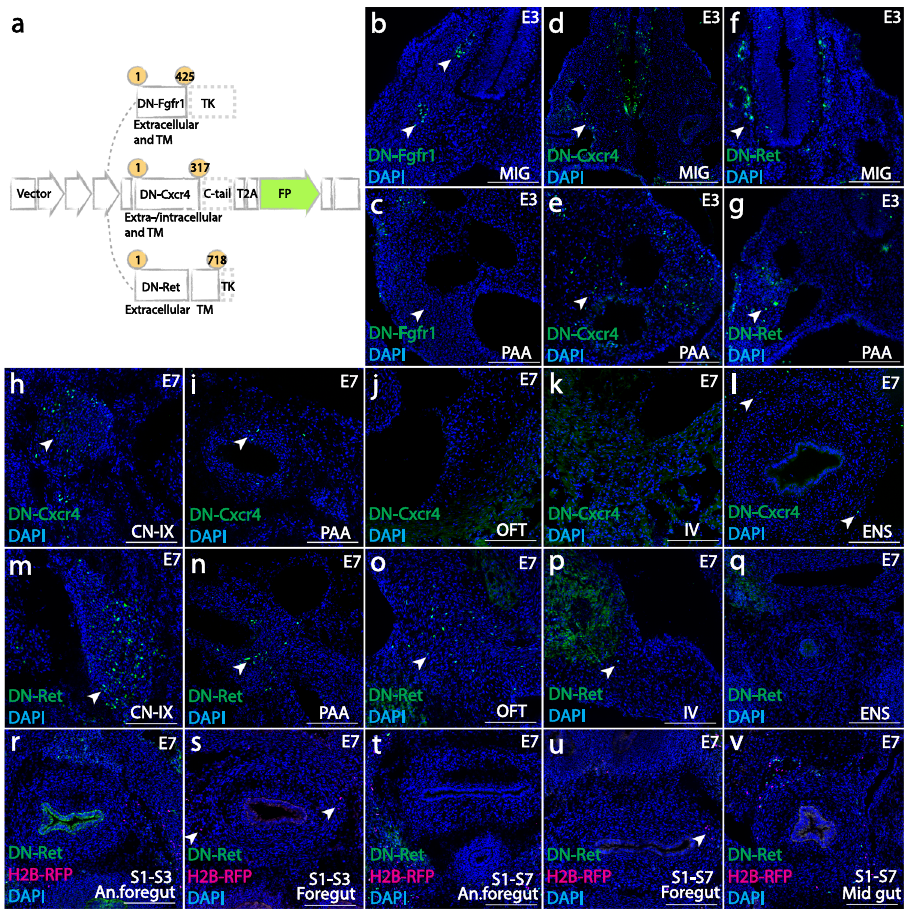
Fig. 5 Molecular cues required for vagal neural crest cells to adopt cardiac and enteric fates. a Viral constructs over-expressing dominant-negative mutants of Fgfr1 (containing amino acids (aa) 1 – 425 of the full-length receptor) and Ret (aa 1 – 718) by truncating the tyrosine kinase domain, and Cxcr4 (aa 1 – 317) with c-tail eliminated. The ranges of amino acids are presented in yellow circles. All mutant constructs are labeled with fl uorescent protein (FP, green). b , c Blocking FGFR1 signaling restricted cardiac neural crest cells within the ganglia ( b , 3/3) and prevented pharyngeal mesenchyme formation ( c , 6/7) at E3. ( d – g ) DN-Cxcr4 and DN-Ret had no apparent effect on initial migration into the ganglia or pharyngeal arches (d (2/2), e (5/5) for Cxcr4; f (3/3), g (8/9) for Ret). h – l At E7, DN-Cxcr4 expressing cells formed cranial ganglia ( h , CN-IX, 2/2), cells around pharyngeal arch arteries ( i , PAA, 7/7), and enteric nervous system ( l , ENS, 6/7). However, no DN-Cxcr4 expressing cells gave rise to the out fl ow septum (j, OFT, 5/5) or interventricular septum (k, IV, 2/2). (m-q) DN-RET expressing cells formed cranial ganglia ( m , CN-IX, 4/4), cells around pharyngeal arch arteries ( n , PAA, 6/6), cardiac out fl ow tract ( o , OFT, 9/9) and interventricular septum ( p , IV, 2/2); however, cells failed to enter the foregut ( q , ENS, 7/9). ( r – v ) The in fl uence of RET signaling on vagal neural crest cells is restricted in the cardiac population. Co-injection of DN-Ret and H2B-RFP (magenta) control virus into somite 1-3 showed that despite both mutant and control virus-infected cells were present in anterior foregut ( r , An. Foregut, 8/8) near the pharyngeal junction, DN-Ret expressing cells failed to enter the foregut ( s 13/15). When the entire vagal population (S1 – S7) was infected, both control and Ret mutant cells reached the anterior foregut ( t , An. Foregut, 10/12). However, only control cells invaded the foregut ( u , 8/9). DN-Ret expressing cells arising from posterior vagal crest cells was able to populate the midgut ( v ) (10/10). Numbers in parenthesis shows the number of images with the phenotype presented in the fi gure out of all images taken. Scale bars: b – v 160 μ